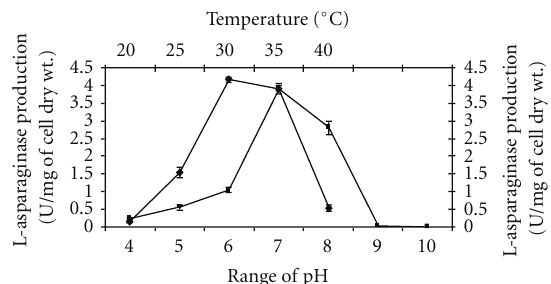
Figure 2: E ff ect of initial pH and temperature on L-asparaginase production by Nocardia levis MK-VL 113 cultured in modified ISP- 5 broth. (Values are the means of three replicates ±